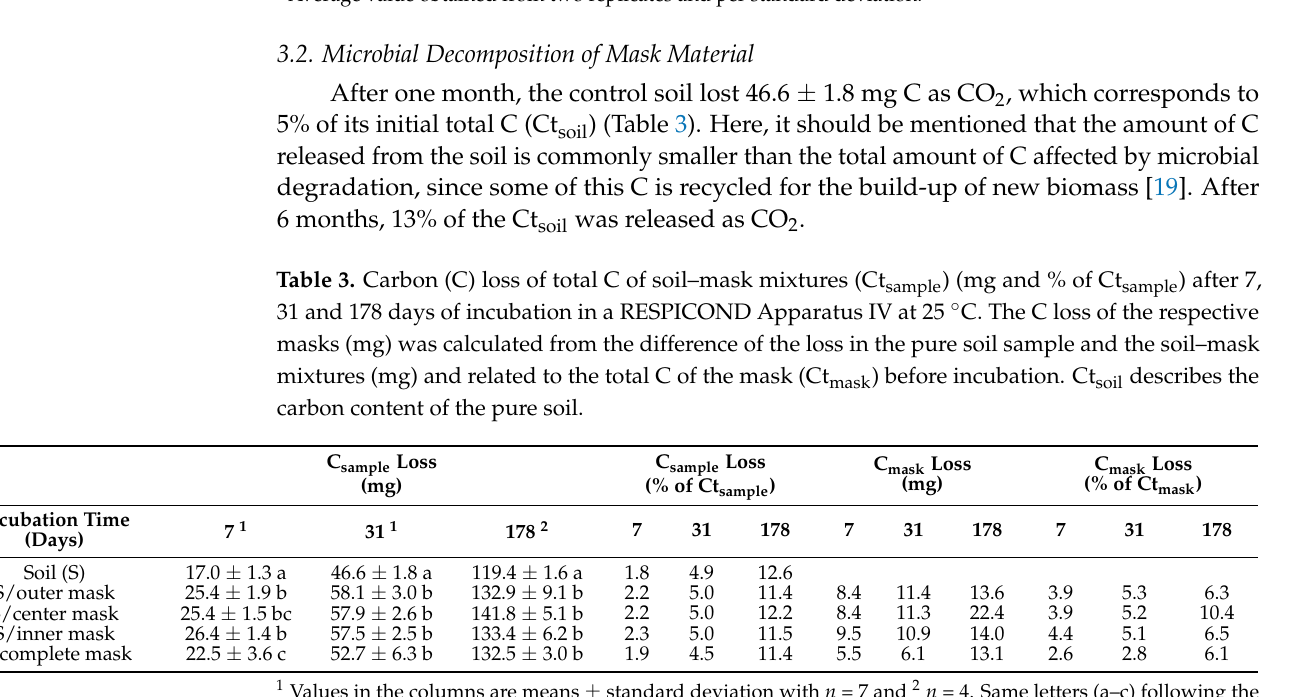
* Average value obtained from two replicates and per standard deviation.